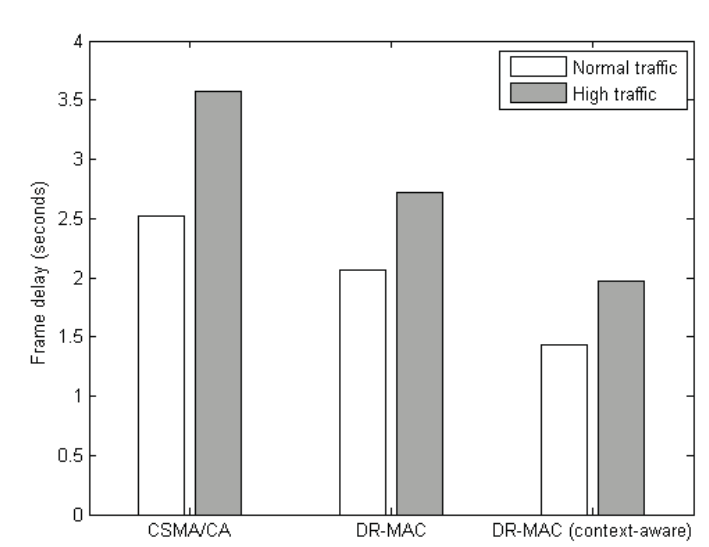
Figure 9. Frame delay of MAC